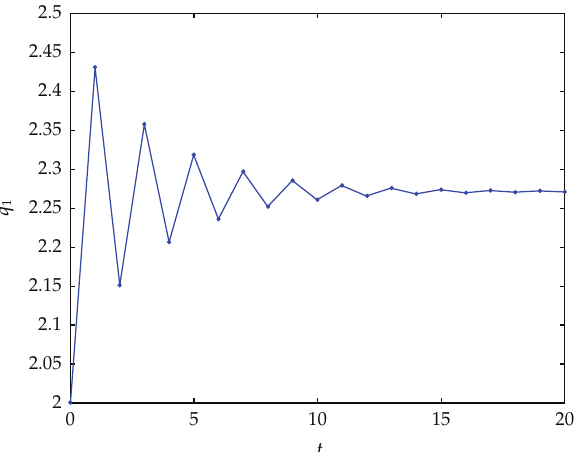
Figure 1: Oscillated convergence to the Nash equilibrium for β (cid:7) 0 . 2 ,α (cid:7) 16 . 0.